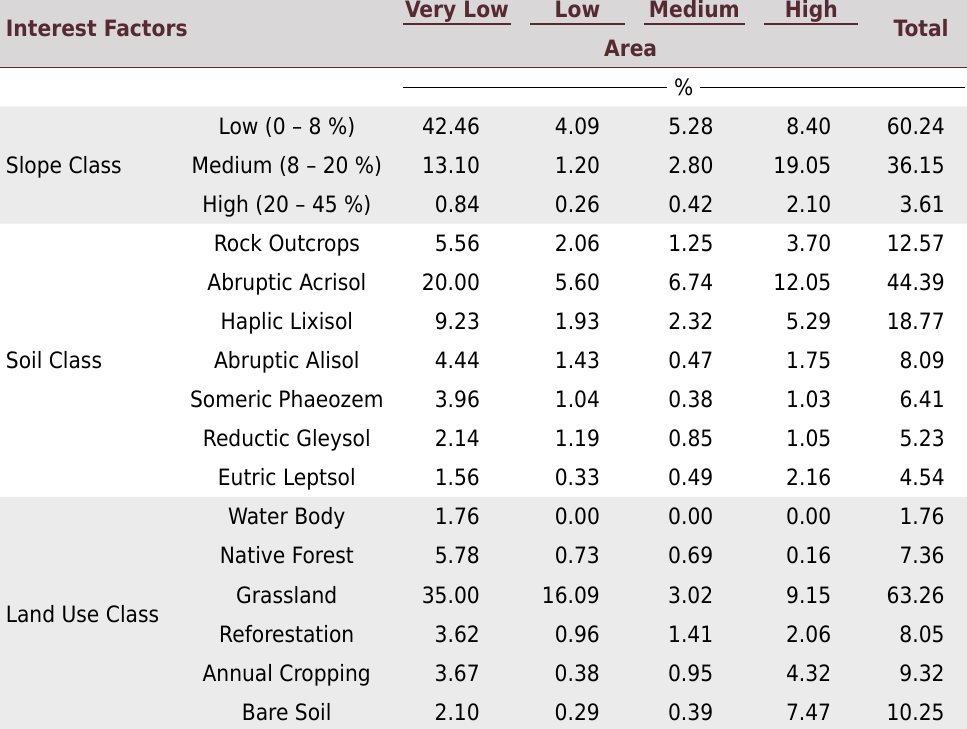
Table 4. Percentages of the area in the Candiota river watershed (CRWsub) according to the ETI classification relation to land slope, soil class and use Interest